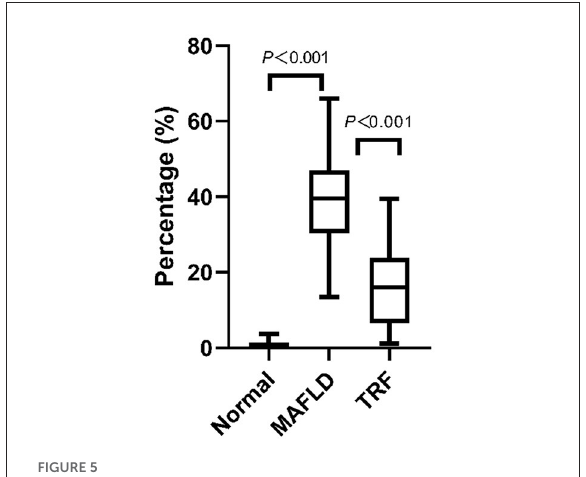
FIGURE5 Area of lipid droplets in liver (%). Four images were randomly selected from each section, and the tissue area occupied by lipid droplets, representing the fat content of the liver, was calculated using Image J software (v1.8.0,National Institutes of Health, USA). The data are presented as